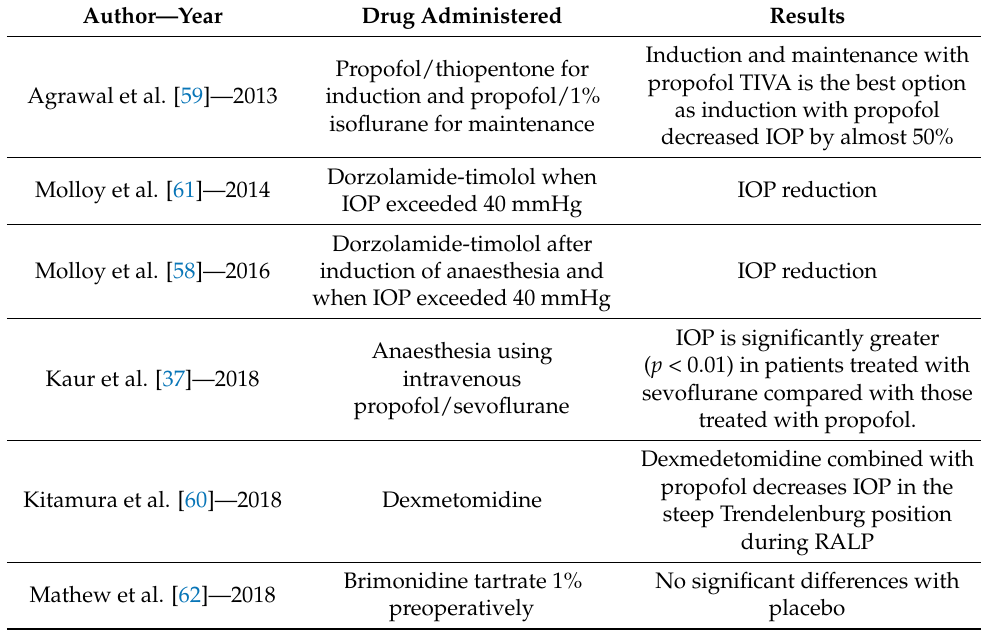
Table 3. Pharmacological strategies determining IOP reduction in